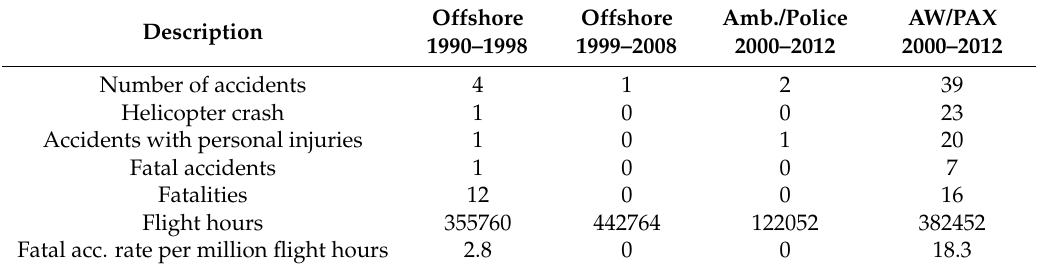
Table 3. Accident records and flight